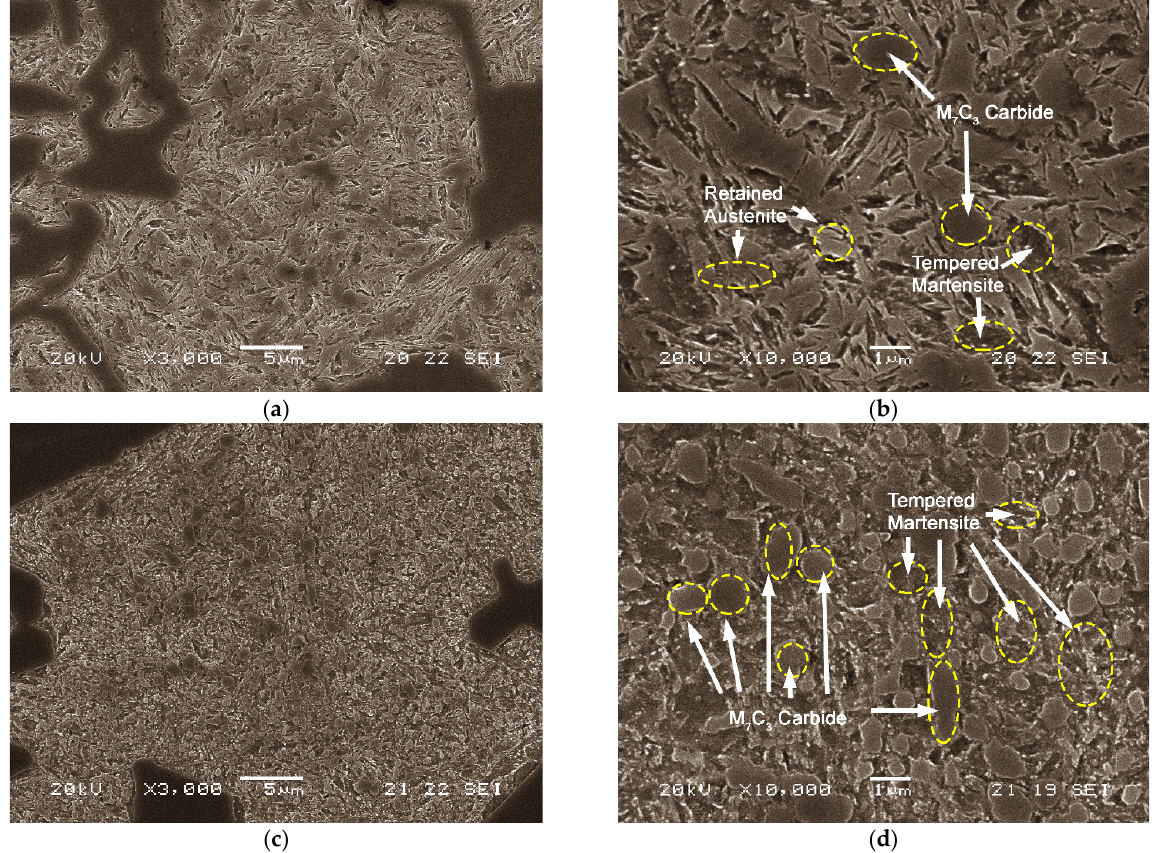
Figure 9. Selected SEM micrographs for experiments 4 and 5. ( a ) and ( b ) correspond to experiment 4; ( c ) and ( d ) correspond to experiment 5.